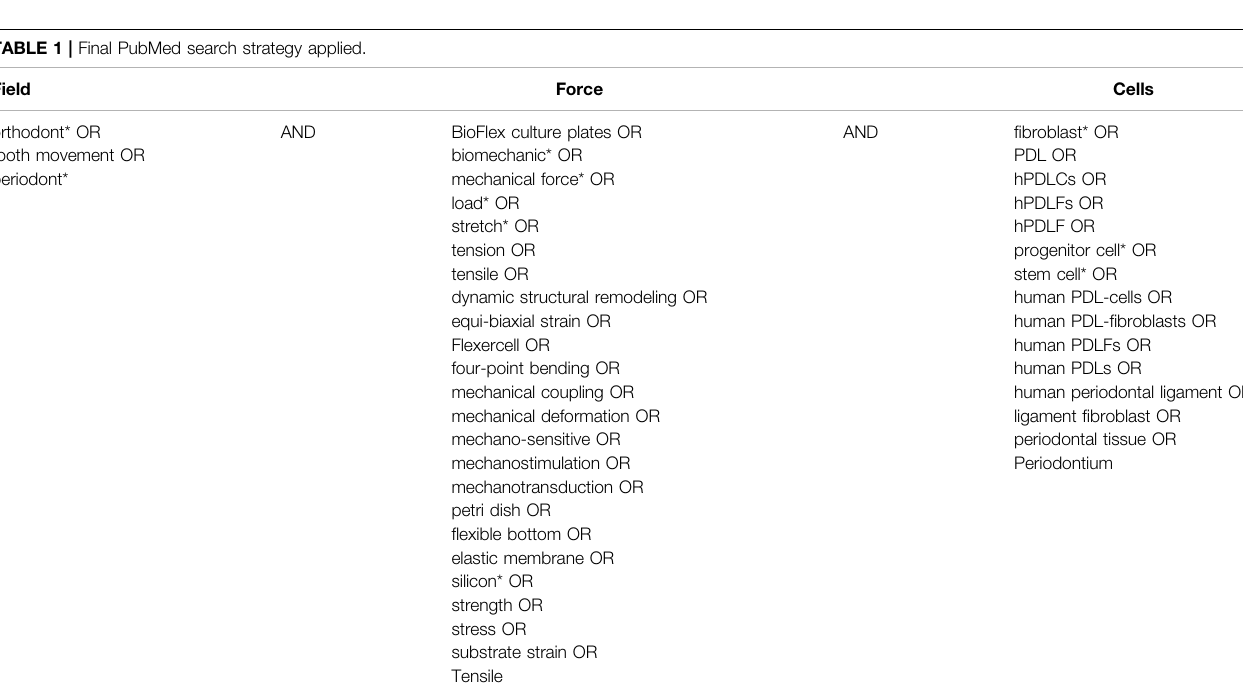
TABLE 1 | Final PubMed search strategy